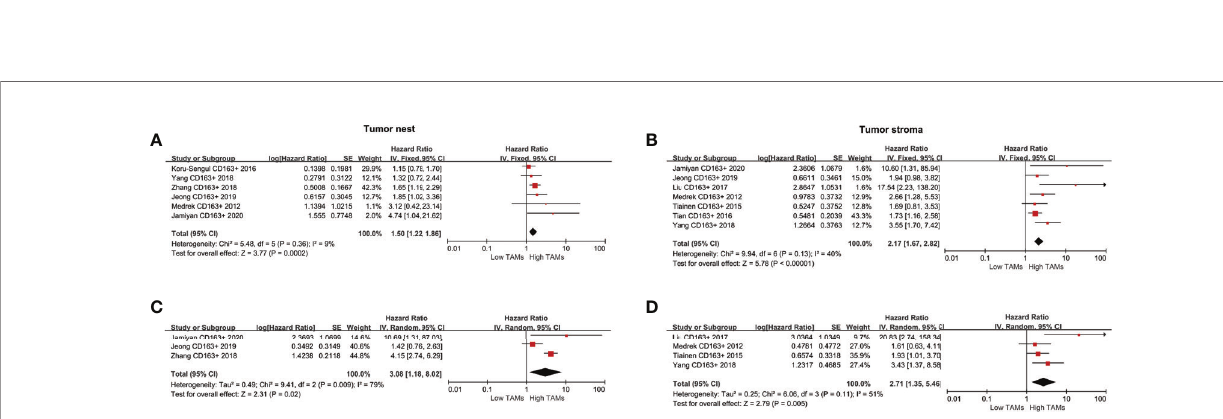
FIGURE 4 | Forest plots of HRs for OS between high and low CD163+ TAM density in BCa patients. (A) HRs of OS in raw data for CD163+ TAMs in the TN of BCa; (B) HRs of OS in raw data for CD163+ TAMs in the TS of BCa; (C) HRs of OS with adjusted measures for CD163+ TAMs in the TN of BCa; (D) HRs of OS with adjusted measures for CD163+ TAMs in the TS of